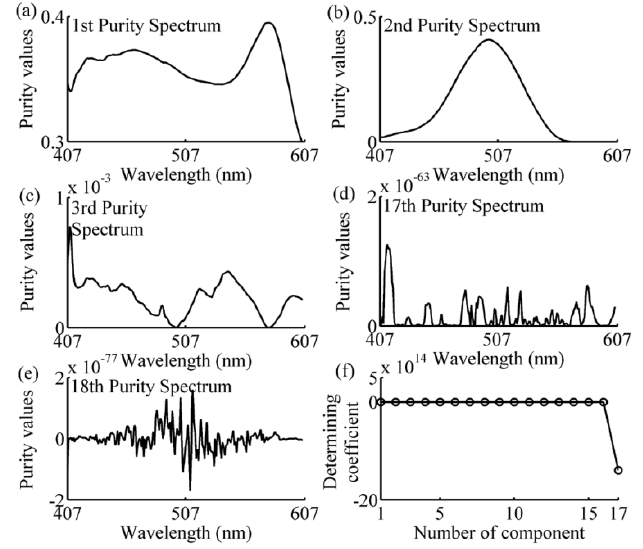
Figure 7. Purity spectra and determining coefficient during the processing of two-component sample’s calibration subset spectra. ( a ) 1st purity spectrum; ( b ) 2nd purity spectrum; ( c ) 3rd purity spectrum; ( d ) 17th purity spectrum; ( e ) 18th purity spectrum; ( f ) determining coefficient. The components are amaranth (100 μg/mL) and carmine (50 μg/mL).